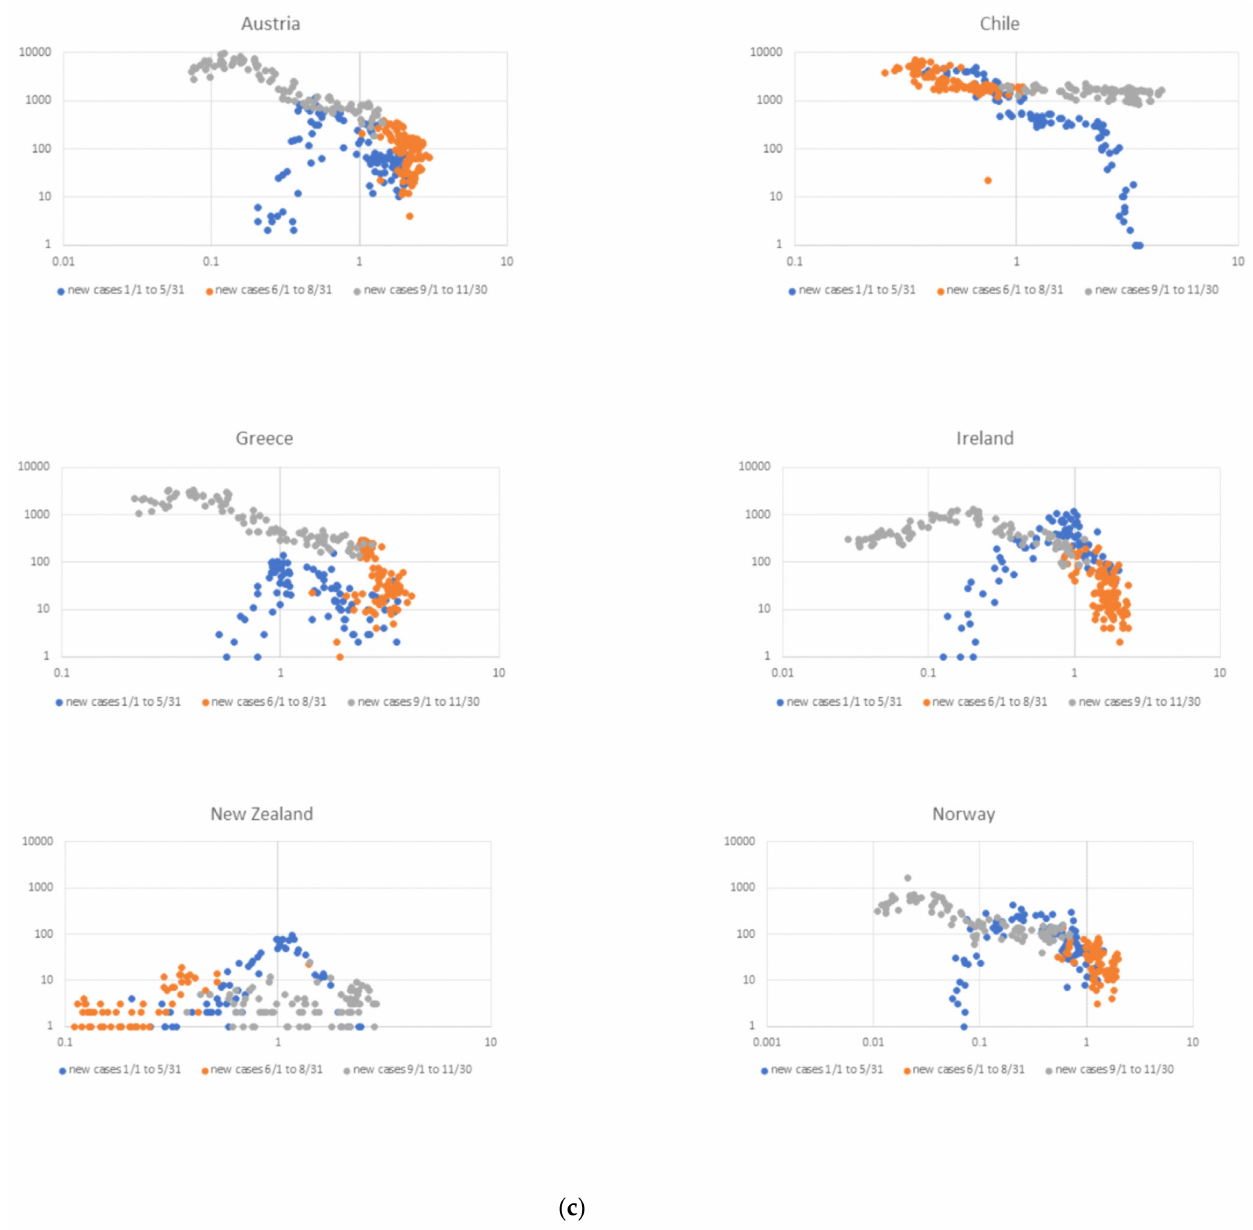
Figure 2. ( a ) Quotidian-independent reporting of case reports vs. UV levels for Group 1 countries. This coarse-grained view shows daily Covid-19 cases (y-axis) and UVDDF levels ( x -axis), marked by a point, on a logarithmic scale. There are three periods shown as follows: 1 January to 31 May (blue), 1 June to 31 August (orange) and 1 September to 30 November (gray). The range of UVDDF can be obtained by projection onto the x-axis, and differs from country to country. ( b ) Quotidian- independent reporting of case reports vs. UV levels for Group 2 countries, as in Figure 2a. ( c ) Quotidian-independent reporting of case reports vs. UV levels for Group 3 countries, as in Figure